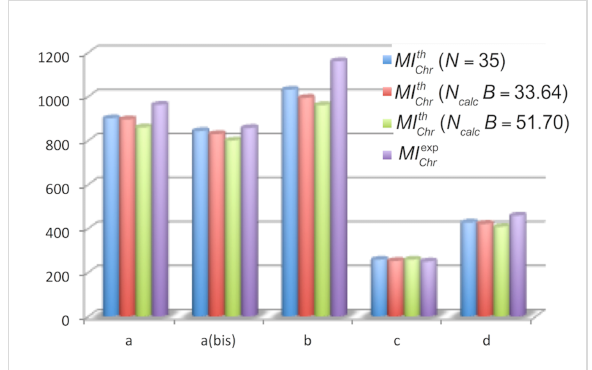
The value of MI Chr also depends on the retention factor ( R f ), especially when the latter is less than 0.2 (Figure 4). An estima- tion of the minimum is also possible by setting an R f to a value close to 0.35, as recommended in the seminal paper of Still et al. [10].